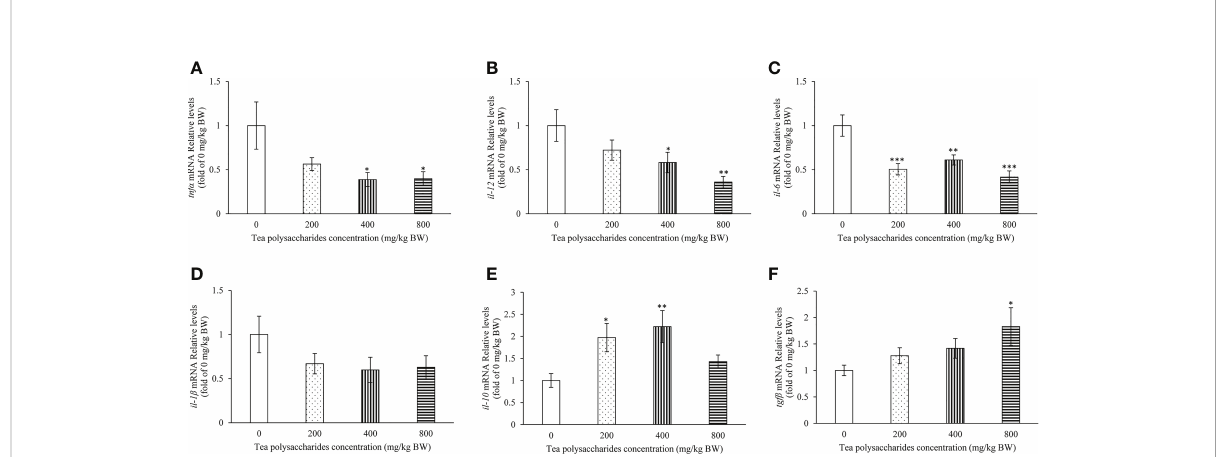
FIGURE 4 Effects of tea polysaccharides on genes expression related to immunity in spleen. (A) tnf a ; (B) il-12 ; (C) il-6 ; (D) il-1 b ; (E) il-10 ; (F) tgf b . At end of the experiment, fi sh were killed and the hepatopancreas was collected for RNA extraction and real-time PCR. All data are shown as mean ± S.E.M. (n = 10-12). Signi fi cant differences were indicated by asterisks, *, P < 0.05; **, P < 0.01; ***, P <